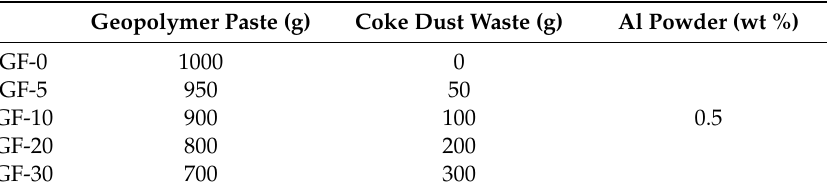
Table 2. Mix proportions of the geopolymer foams.